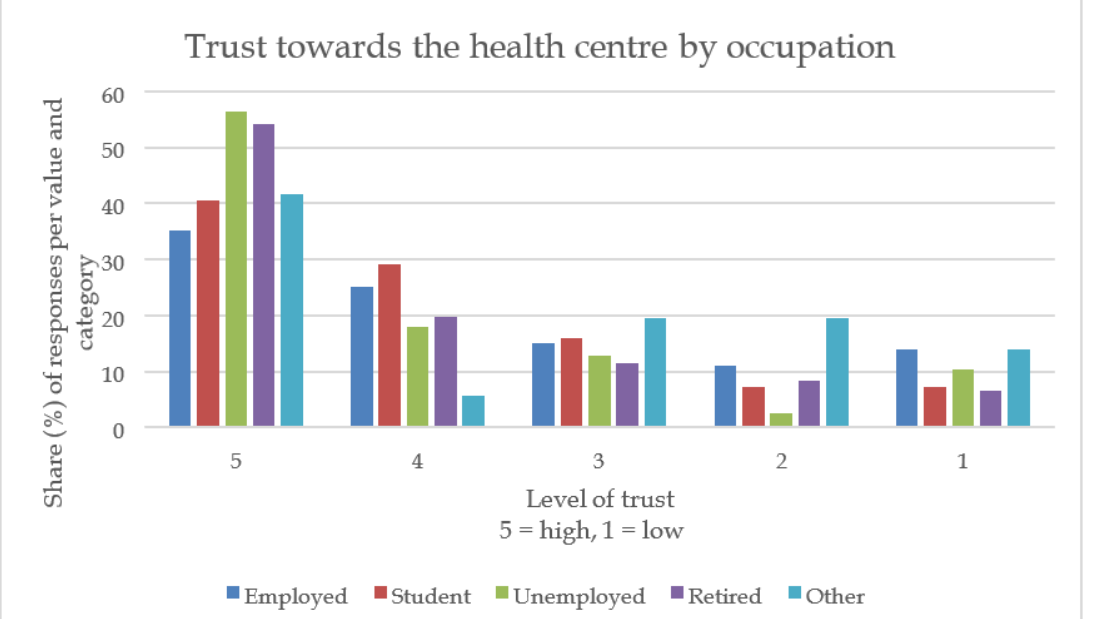
Figure 8. Trust towards the health centre and occupation. Percentage per reported value on scale 5-1 Employed n=100 (100%), Student, n=69 (100%), Unemployed n=39 (100%), Retired n=61 (100%), Other n=11 (100%). Total n=303.